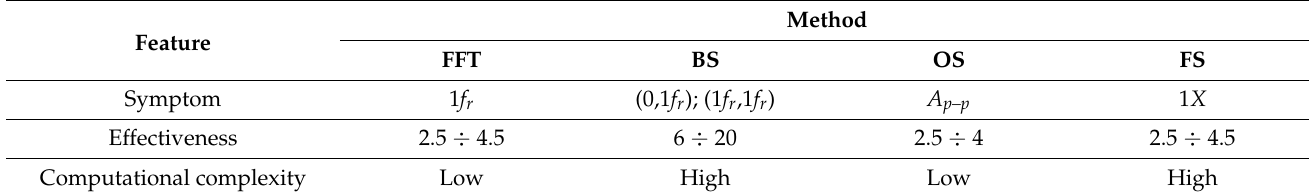
Table 1. Comparison of properties of methods used for diagnosis of PMSM